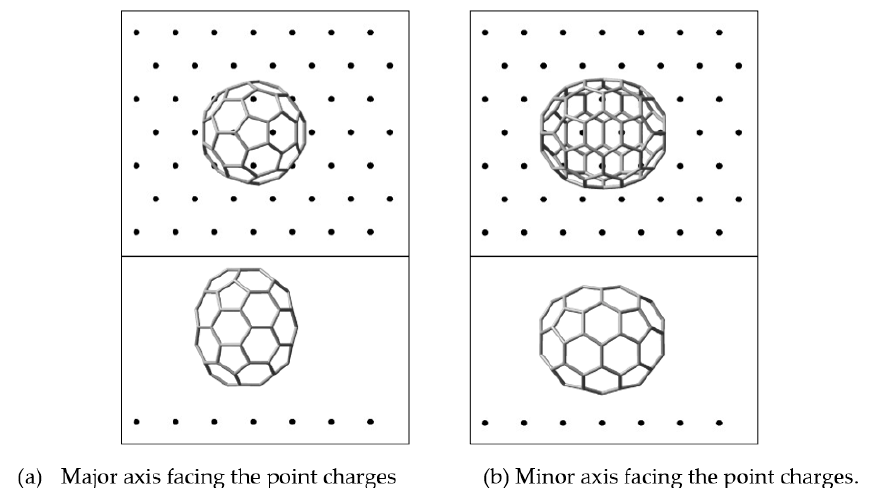
Figure 3. Major axial in ( a ) and minor axial in ( b ) orientation arrangements of a C 70 fullerene spheroid molecule facing the model surface of the gate electrode made up of point charges located on 7 × 7 mesh points. ( b ) Here, minor axial orientation arrangement of a C 70 fullerene molecule facing the point charges is a model of the major axis of a C 70 fullerene spheroid facing the Au source and drain electrodes.